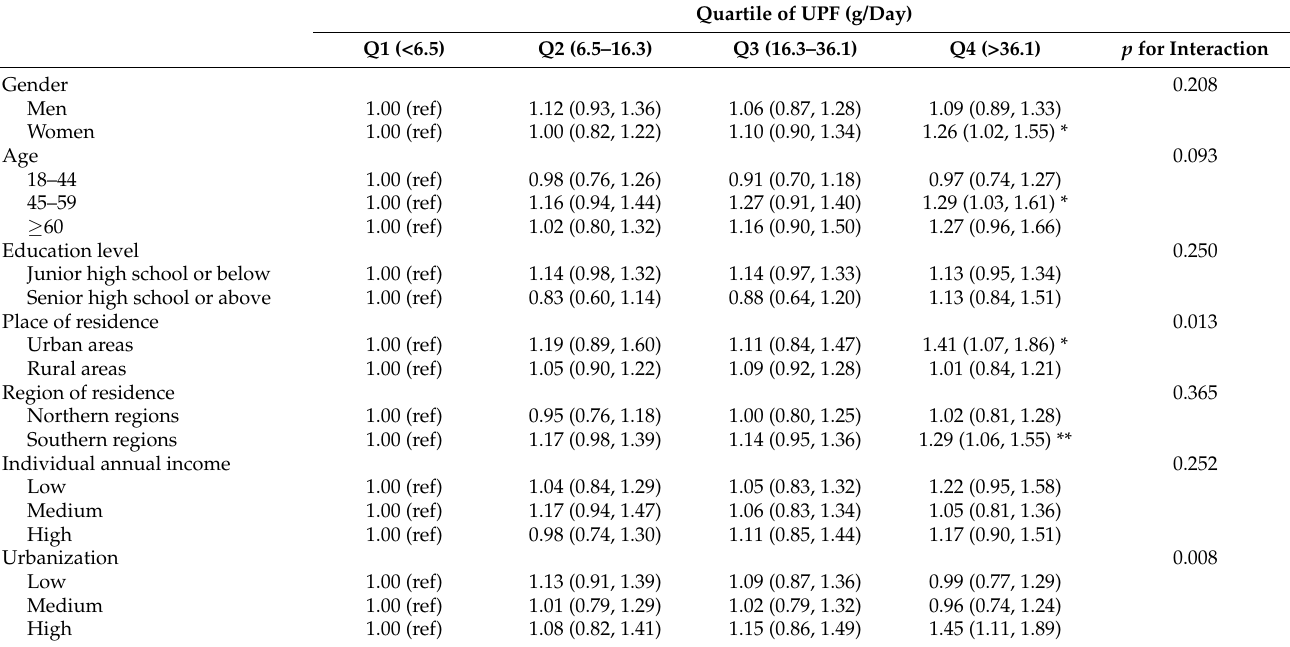
Table 3. Stratified analyses of MetS risk and UPF